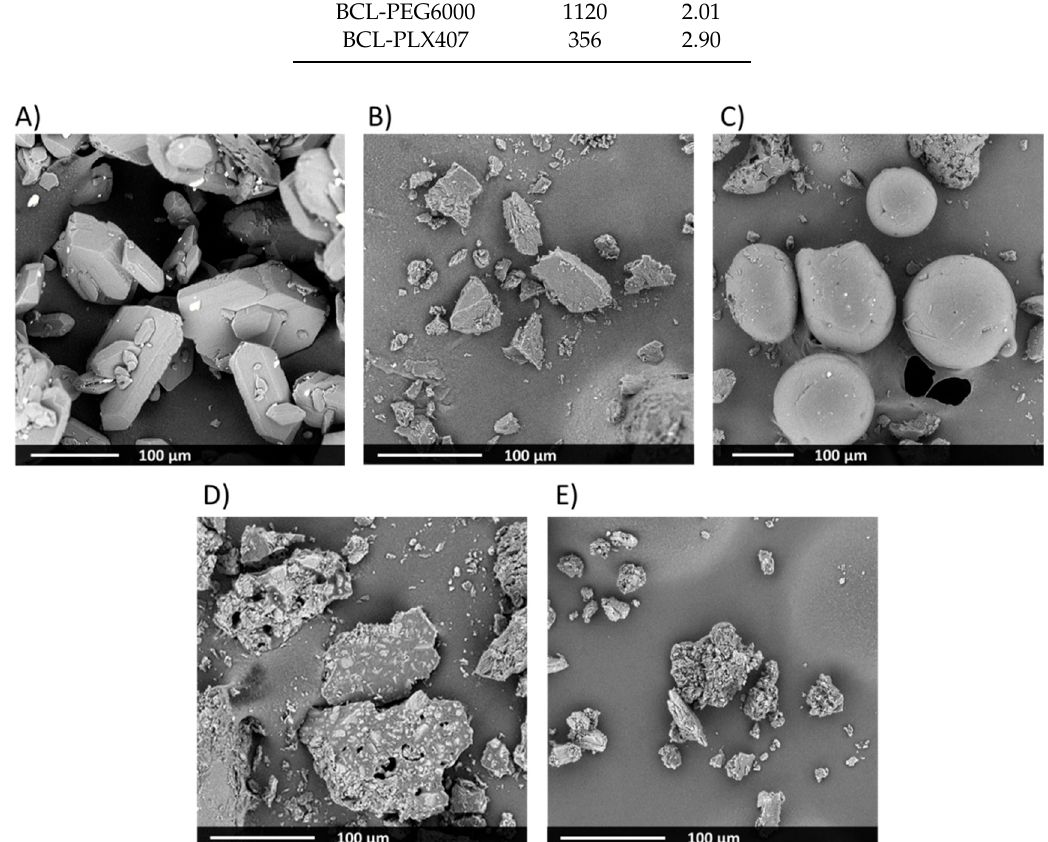
Figure 1. SEM image of raw bicalutamide ( A ), PEG6000 ( B ), PLX407 ( C ), BCL-PEG6000, ( D ) and BCL-PLX407 ( E ) solid dispersions.